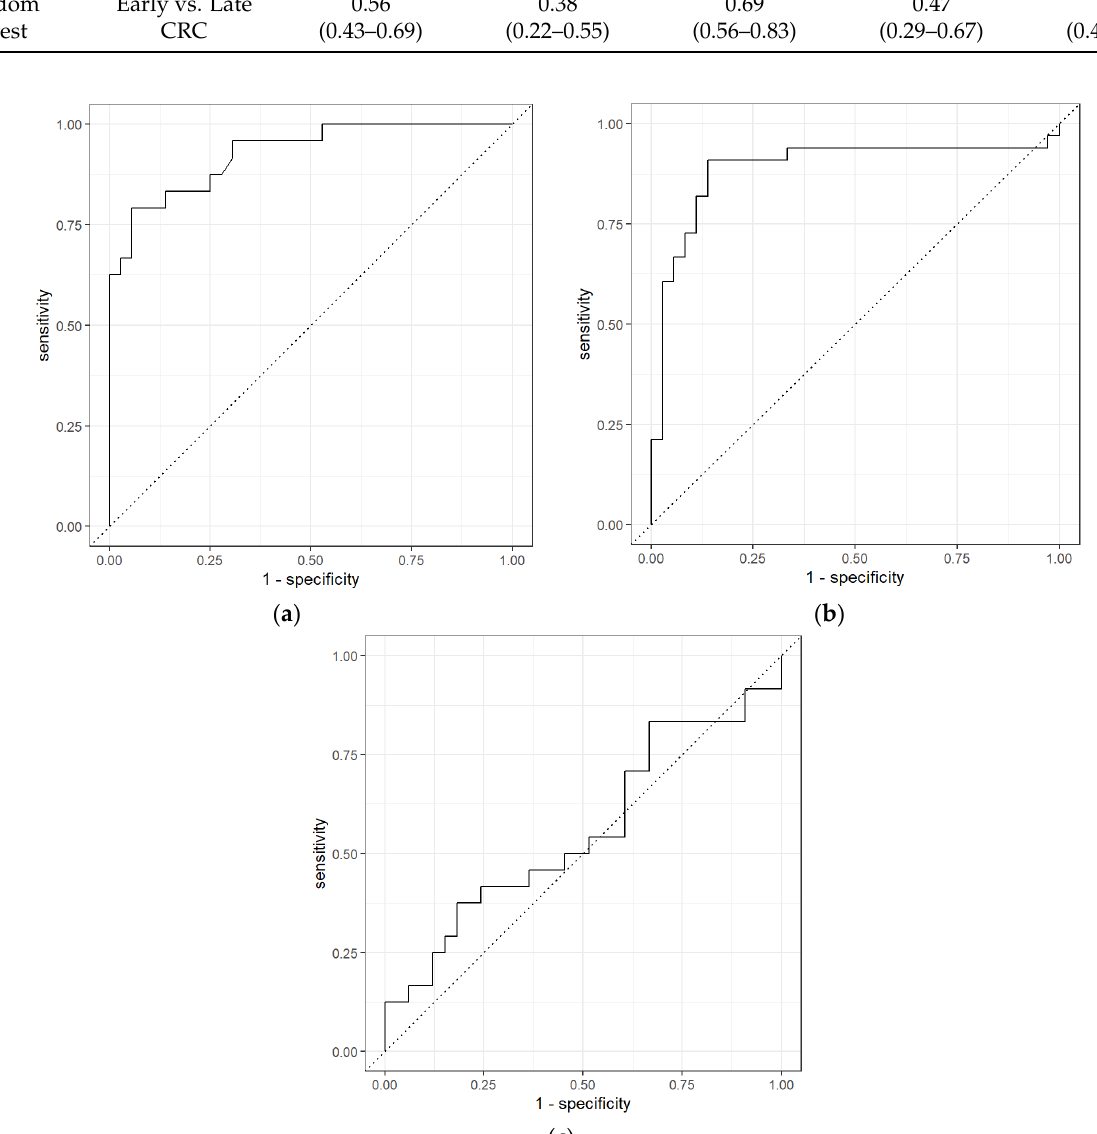
Figure 9. ROC for different stages of CRC vs. non-Cancer: ( a ) early-stage CRC vs. non-cancer using Random Forest classifiers, ( b ) late-stage CRC vs. non-cancer using Neural Network, and ( c ) early-stage CRC vs. late-stage CRC using Neural Network using the GC-TOF-MS analytical device.